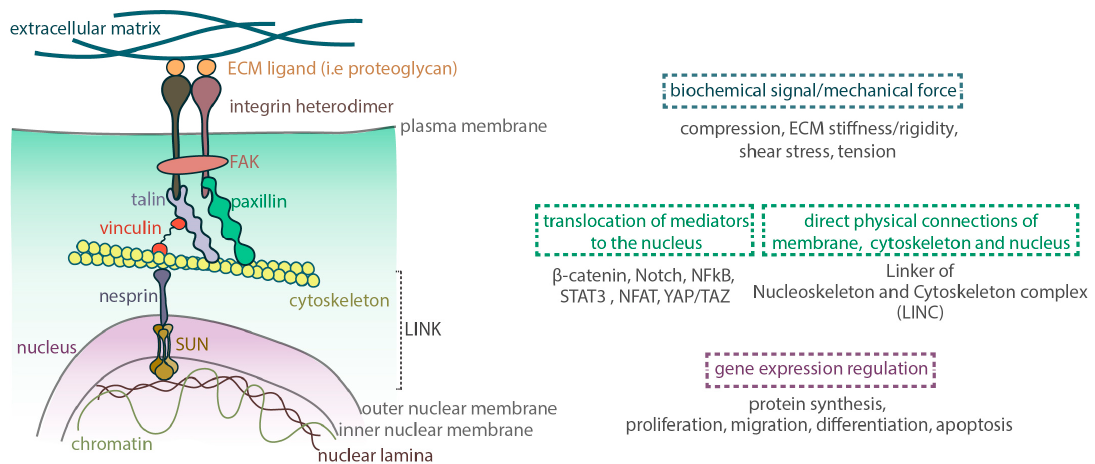
Figure 3. Signal propagation to the nucleus. Biochemical and mechanical stimuli are transferred to the nucleus and become e ff ective through i) direct physical interactions of the membrane, the cytoskeleton and the nucleus and / or ii) the translocation of activated mediators from the cytoplasm to the nucleus. Eventually, stimuli surpassing a certain threshold can instruct transcriptional changes and regulate the gene expression pattern of a given cell.